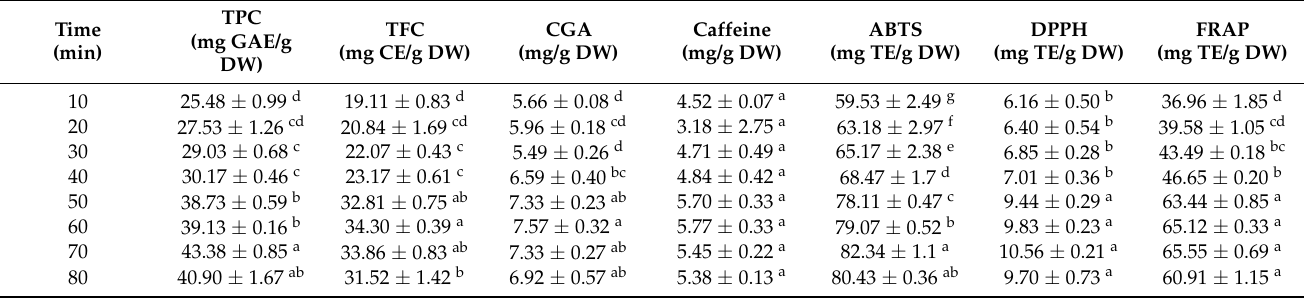
Table 4. Effect of radiation time on recovery of bioactive compounds and antioxidant from coffee pulp.